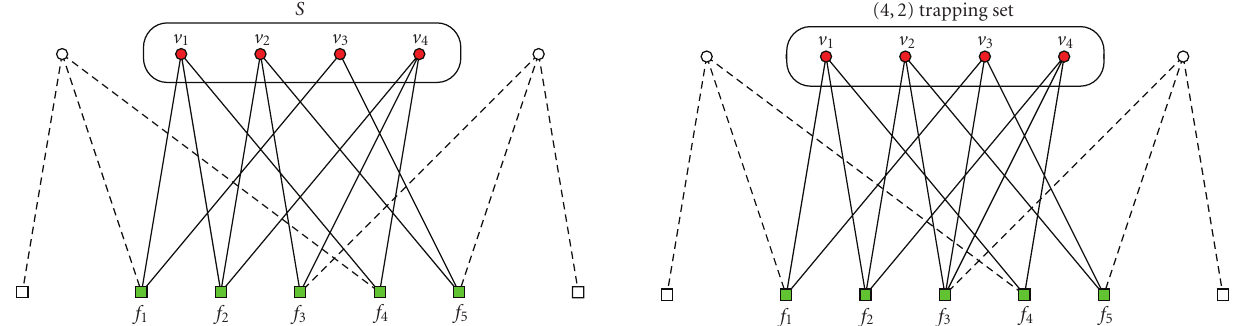
Figure 2: Example of a stopping set in the Tanner graph of an LDPC code.